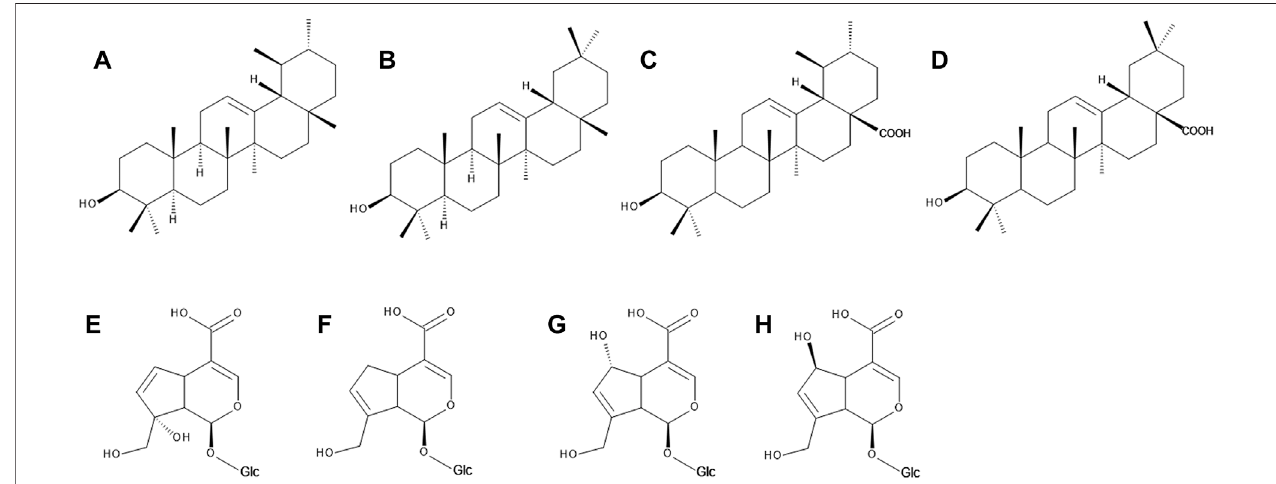
FIGURE 3 | The chemical structures of α -amyrin (A) , ß-amyrin (B) , usolic acid (C) , oleanolic acid (D) , monotropein (E) , geniposidic acid (F) , deacetylasperulosidic acid (G) and scandoside (H) .